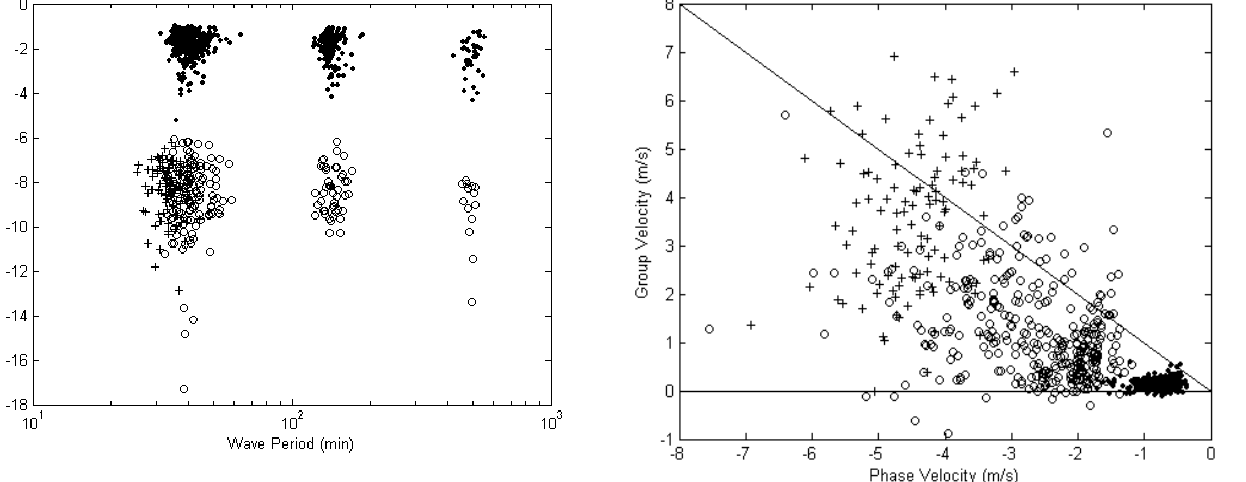
Fig. 11. Scattering plot of vertical wave length vs characteristic Fig.11 Scattering plot of vertical wave length vs characteristic wave period for part of the wave period for part of the sampled wave packets. The negative sampled wave packets. The negative value of the wave length represents negative phase value of the wave length represents negative phase velocity. Dot: velocity. (Dot) Denote the wave packets sampled by the windows T2Z1, T3Z1, and denote the wave packets sampled by the windows T2Z1, T3Z1, and T4Z1; (Open circle) Sampled by windows T2Z4, T3Z4 and T4Z4; (Cross) Sampled by T4Z1; open circle: sampled by windows T2Z4, T3Z4 and T4Z4; cross: sampled by the window T1Z4. the window T1Z4.